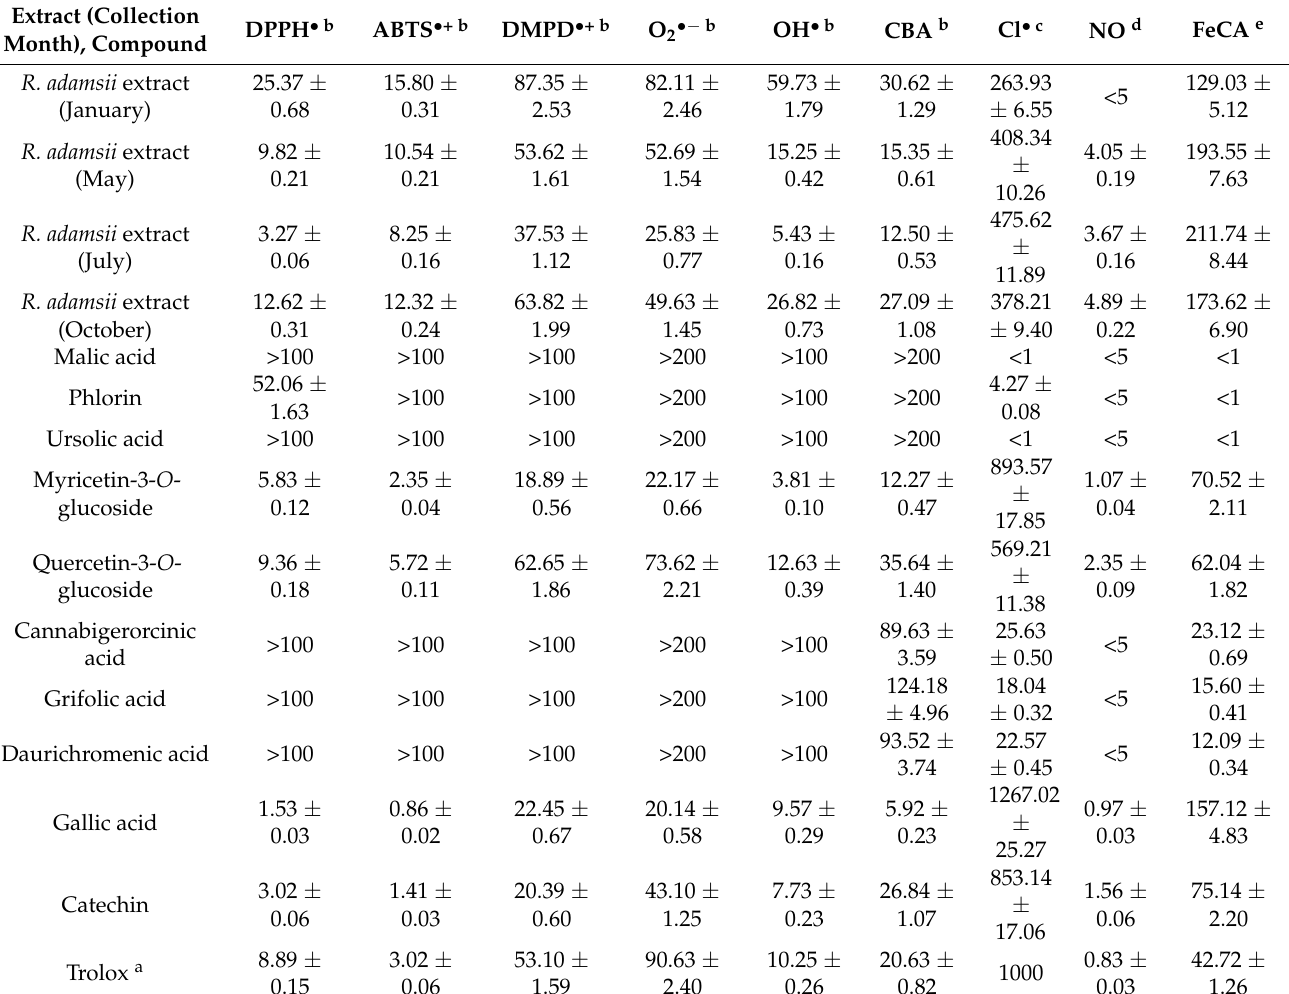
Table 5. Antioxidant activity of R. adamsii extracts and selected